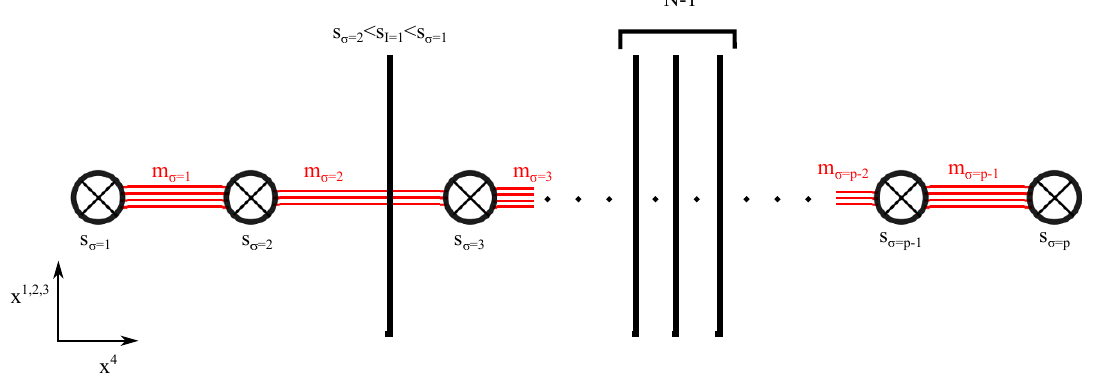
Figure 8 . This (cid:12)gure illustrates the Hanany-Witten frame of the brane con(cid:12)guration in which we are studying the space of supersymmetric vacua of the wold volume theory of D1-branes. Here there are m (cid:27) D1-branes (red) that end on the NS5-branes ( (cid:10) ) at x 4 = s (cid:27) ; s (cid:27) +1 and the D3-branes (black) give rise to fundamental domain walls at the intersection with D1-branes x 4 = s I .